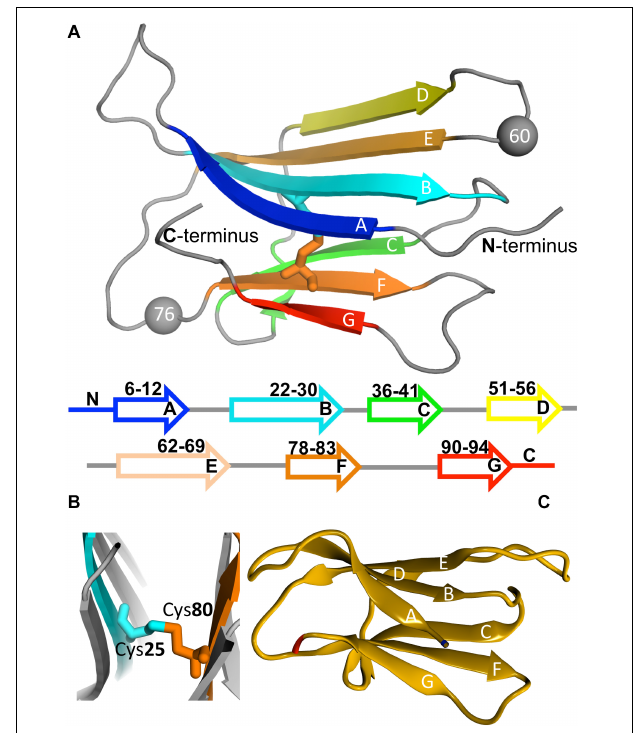
FIGURE 3 | Protein beta-2-microglobulin ( β 2m). Three-dimensional structure of β 2m highlighting the 7 beta-strands, organized in two beta-sheets (comprising strands A-B-E-D, and C-F-G, respectively), and the position of Trp60 (which is a key residue in aggregation) and Asp76, which is mutated to Asn in the D76N mutant (PDB ID: 4FXL) (A) . A cysteine bond links strands B and F (B) . Native structure of the (cid:49) N6 structural variant lacking the N-terminal hexapeptide (PDB ID: 2XKU) (C)